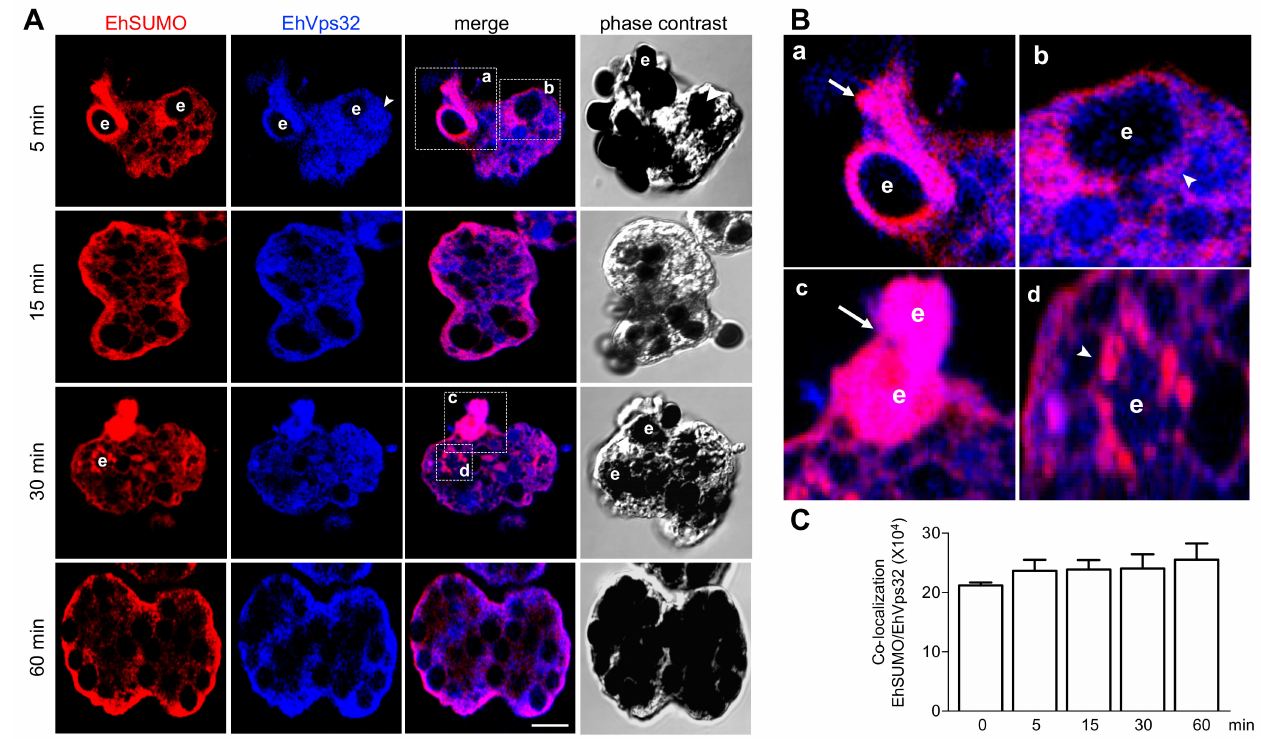
Figure 9. Location of EhSUMO and EhVps32 during phagocytosis. Trophozoites were incubated for 5, 15, 30, and 60 min with erythrocytes ( e ) and processed for confocal microscopy. ( A ) Immunofluorescence assays, using α -EhSUMO (red) and α -EhVps32 (blue) antibodies. Scale bar = 10 µ m. ( B ) Magnification of squares presented in ( A ). Arrow: colocalization of proteins in a channel-like structure ( a ) and in erythrocytes ( c ). Arrowhead: colocalization of both proteins surrounding a vesicle with erythrocytes ( b , d ). ( C ) Quantification of EhSUMO and EhADH colocalization in the whole